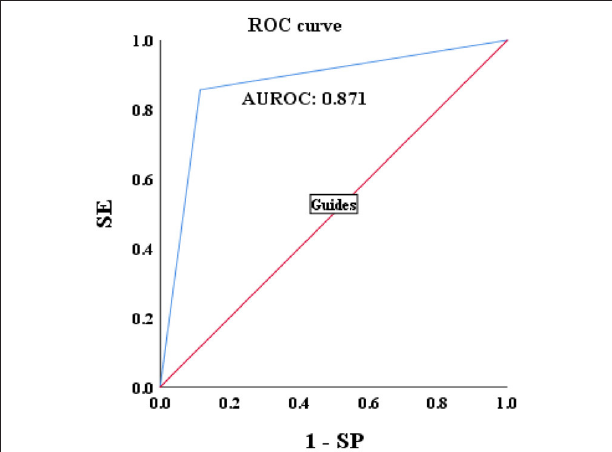
TABLE 4 | Validation results of noninvasive diagnosis model for CBI patients with concurrent NAFLD. Formula